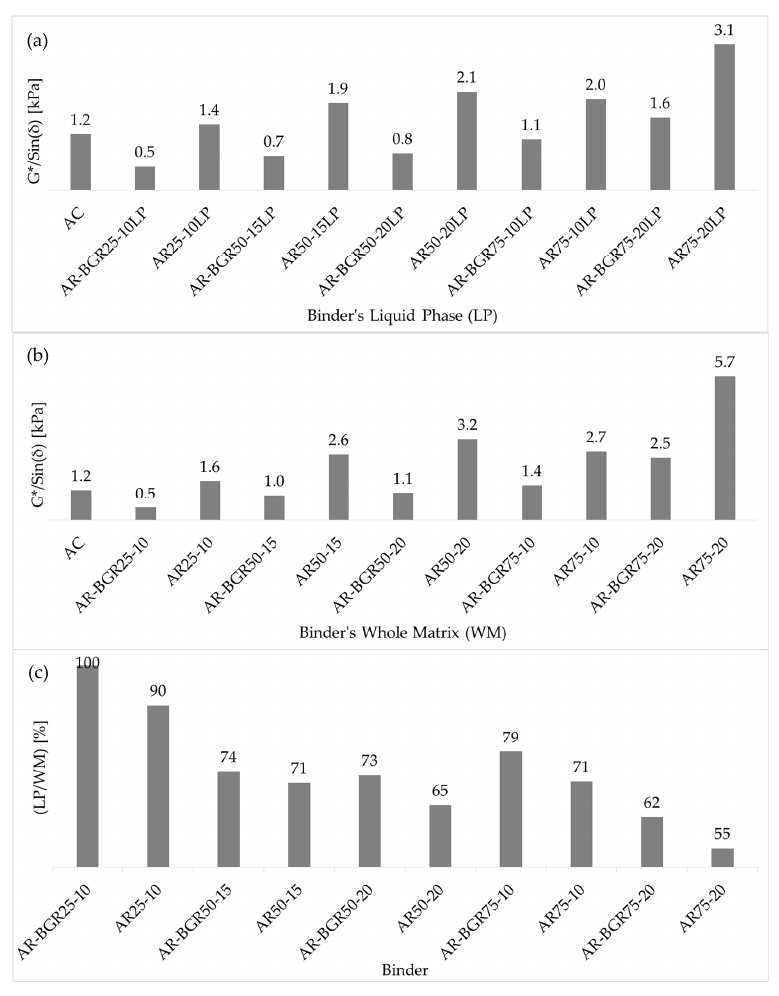
Figure 2. Comparing the rutting parameter of the five asphalt–rubber–guayule binders to the corresponding asphalt–rubber binders at 64 °C: ( a ) liquid phase; ( b ) whole matrix; ( c ) percentage of liquid phase per whole matrix (LP / WM%) as a function of complex shear modulus / sin phase angle (G* / Sin( δ